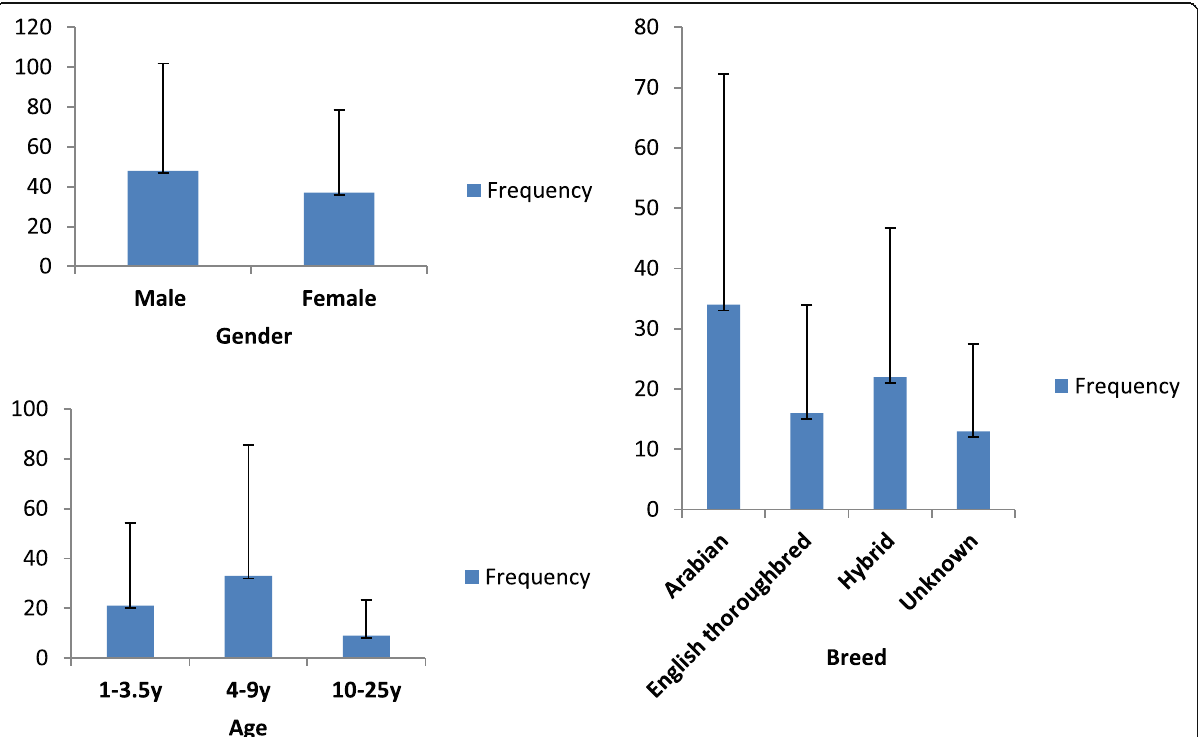
Fig. 1 Owners responses to part (A) questions. Results are represented as frequency of responses; error bars represent their